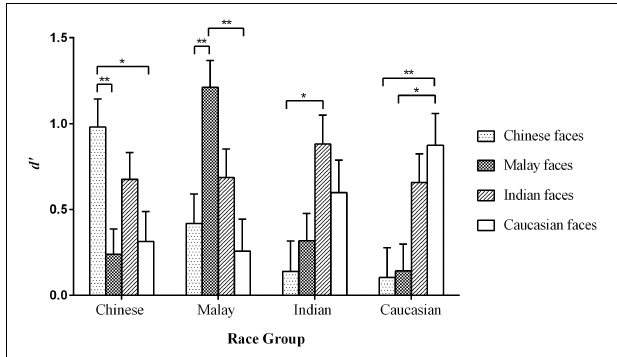
FIGURE 2 | Recognition accuracy of Chinese, Malay, Indian, and Caucasian participants for own- and other-race faces in the face recognition task. Error bars represent standard errors of the mean (** p < 0.01, * p < 0.05).